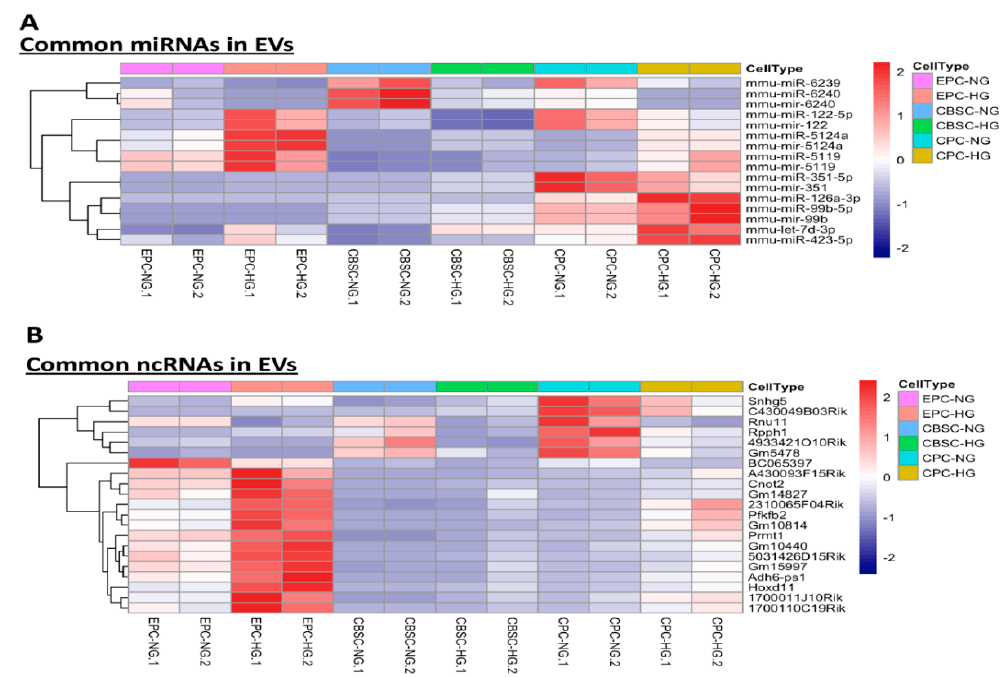
Figure 5. Heatmap of di ff erentially expressed common miRNAs and ncRNAs among hyperglycemic EVs. ( A ) Heat map shows di ff erentially expressed miRNAs. ( B ) Heat map shows di ff erentially expressed